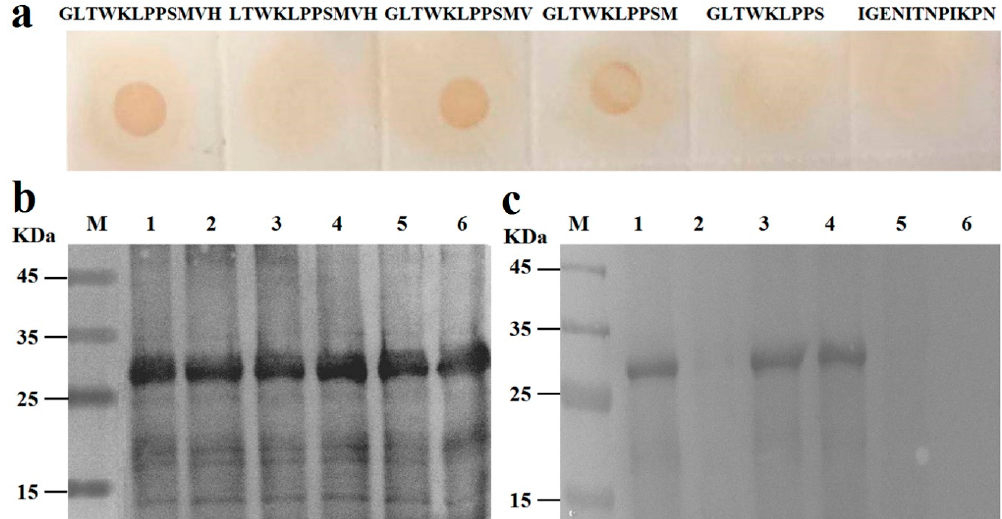
Figure 8. Identification of the essential amino acid of the epitope Pep0: ( a ) Identification of the essential amino acid for the epitope Pep0 based on anti-Pep0 rabbit sera reactivity with the synthesized peptides in the dot blotting assay; ( b ) the reactivity of the expressed mutated peptides to anti-GST (Glutathione S Transferase) mAb; ( c ) the reactivity of the expressed mutated peptides to mAb 4E6. M: Protein marker; lane 1, GST-GLTWKLPPSMVH; lane 2, GST-LTWKLPPSMVH; lane 3, GST-GLTWKLPPSMV; lane 4, GST-GLTWKLPPSM; lane 5, GST-GLTWKLPPS; lane 6, GST negative